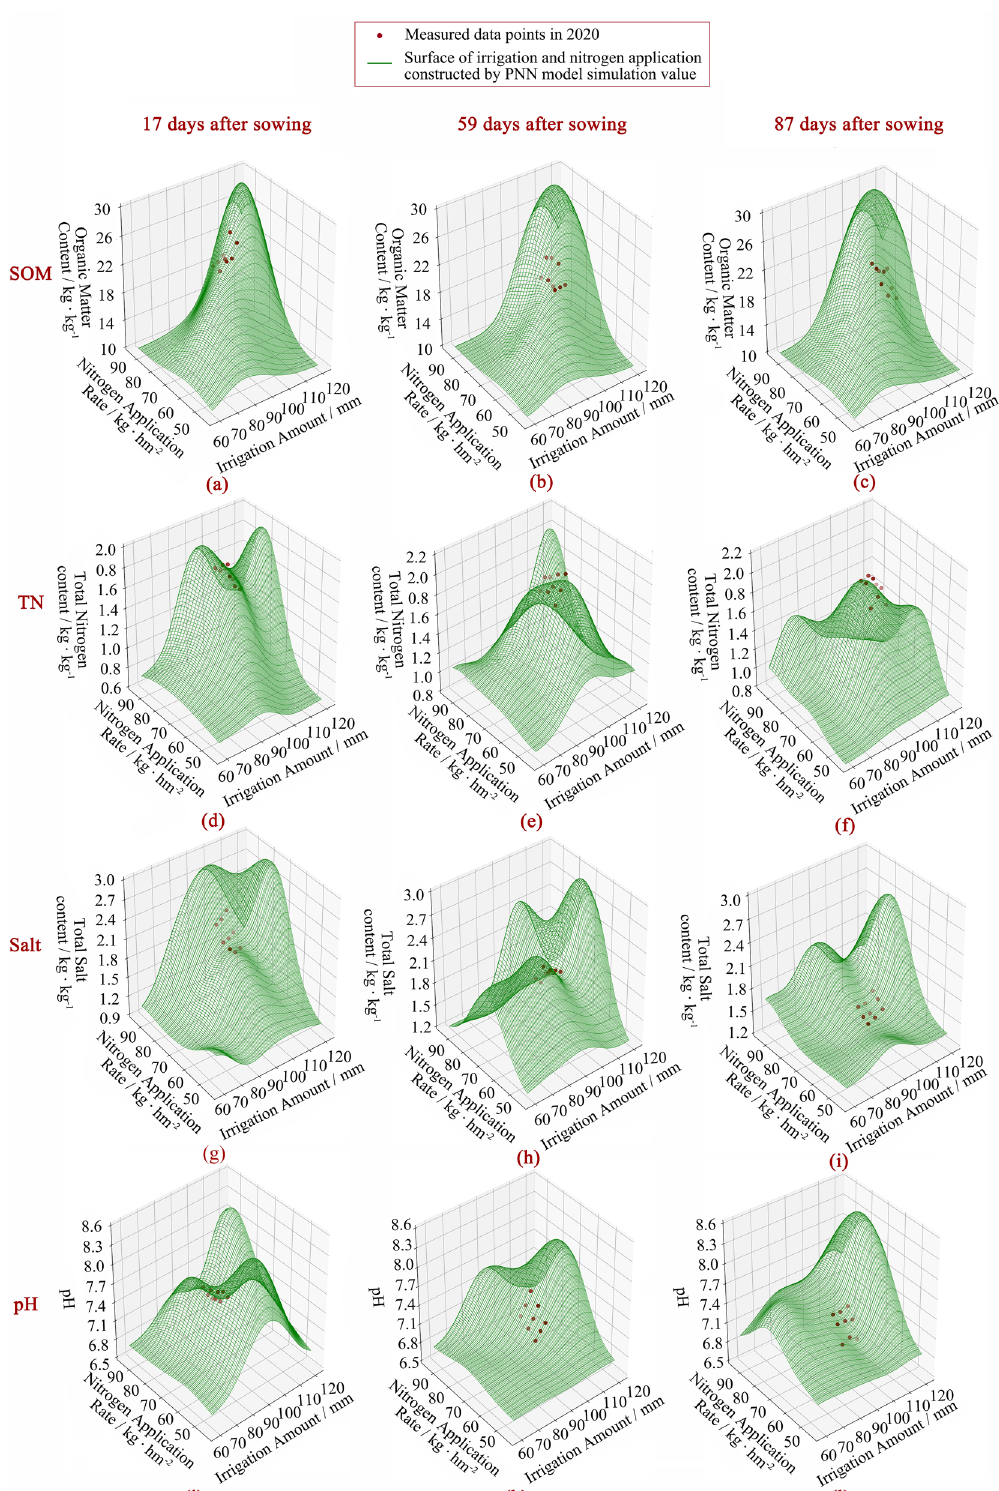
Figure 7. Surface of soil fertility index after irrigation and nitrogen application at seeding, jointing, filling stage of maize. The green surface is the water-nitrogen interaction surface with a single index change, which is obtained by PNN training based on the measured data from 2018 to 2019. The red dots are the measured values of corresponding indexes under the reset irrigation and nitrogen application levels in